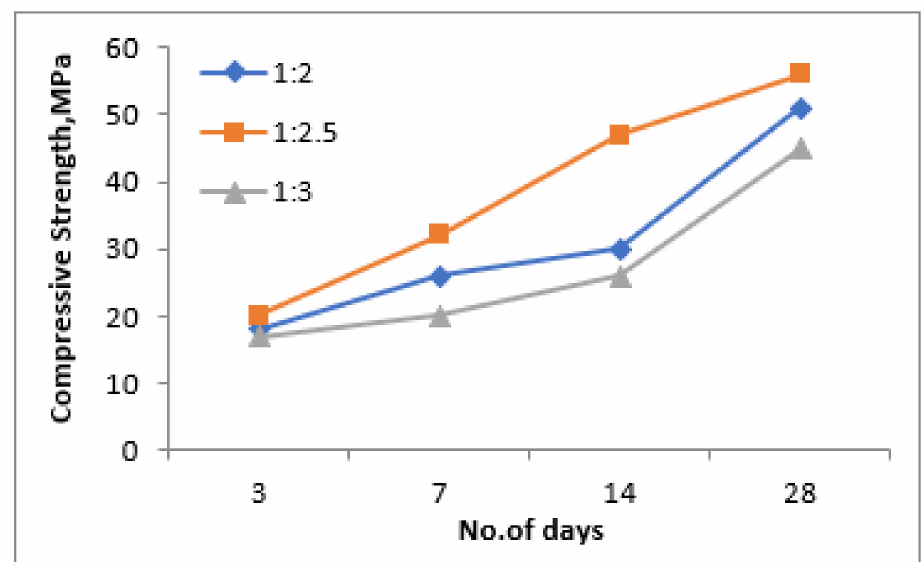
Figure 9. Compressive strength for different fly ash and steel slag